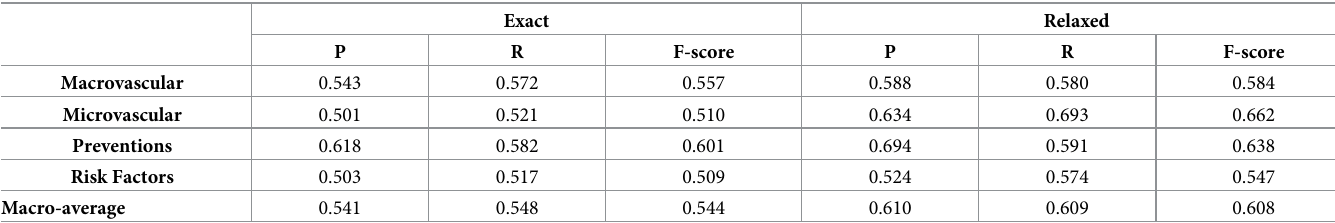
Table 3. IAA for EHRs using exact and relaxed matching criteria.